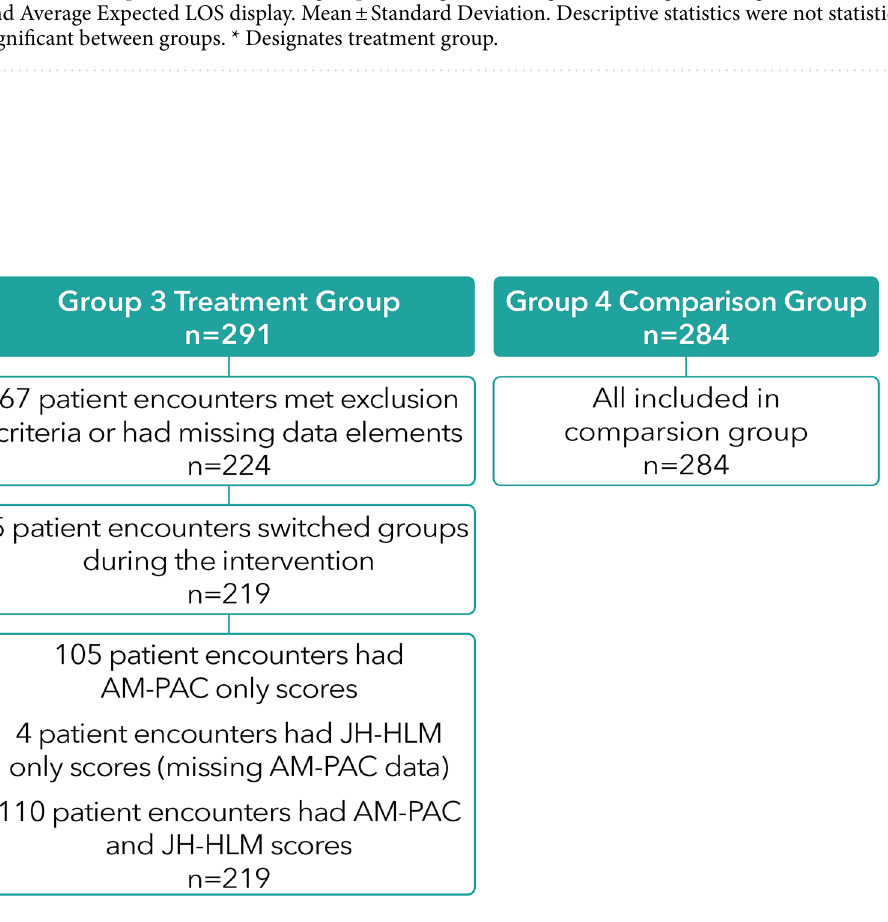
Figure 1. Determining treatment subgroups from the